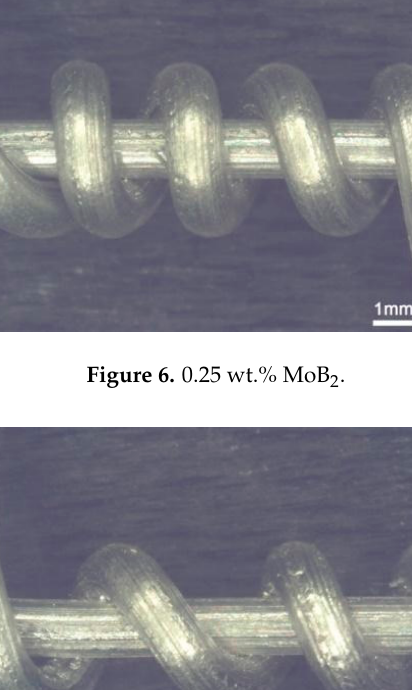
Figure 5. Pure Al wire used for reference.